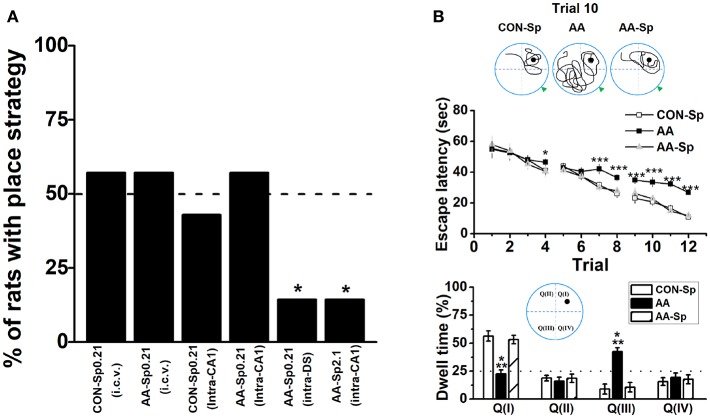
Infusion of Sp-cAMP into the HPC could mitigate the response-strategy bias and spatial learning deficits induced by AA. (A) The percentage of animals that used a place strategy. Intracerebroventricular (i.c.v.) infusion of Sp-cAMP into HPC (intra-CA1) or DS (intra-DS) was administrated to AA-induced rats at three different time points around Y-maze learning task. (*P < 0.05 vs. only AA-Sp0.21-intraCA1). n = 7 for each group. (B) Sp-cAMP reduced travel path during the 10th trial of location learning test (top). Traces of travel path following injection of the control (Sp-cAMP) (top-left), AA (top-middle), and AA combined with Sp-cAMP (top-right) were presented. The dark circles designate the position of the hidden platform and the gray triangle represented the starting position of the previous trial (trial 9). Escape latency (middle) and dwell time (bottom) were calculated for each trial during the 12-trial location learning task The distribution of quadrants in the MWM test (bottom insert). (*P < 0.05, ***P < 0.001, AA vs. CON-Sp or AA-Sp) n = 7 for each group.